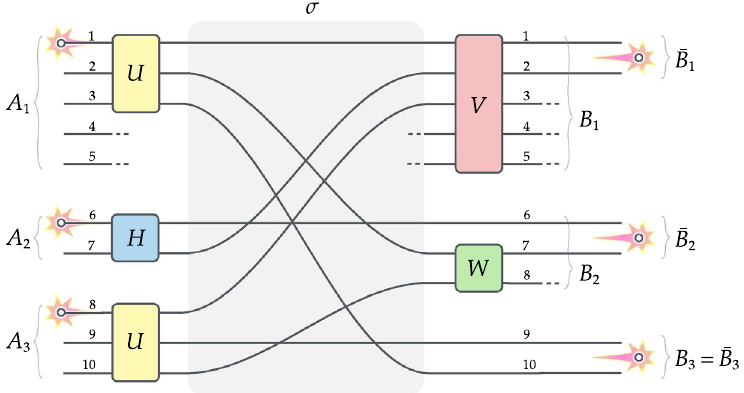
Figure 1. No-touching design for arbitrary state of three qubits. Three independent identical particles entering the optical circuit undergo a sequence of transformations which consists of local unitaries U , H and U on subsystems A 1 , A 2 and A 3 , followed by permutation of the paths σ , and again local unitaries V and W on subsystems B 1 and B 2 . Post-selection on a single particle in each of the dual-rail qubits generates an arbitrary state of three qubits ¯ B 1 , ¯ B 2 and ¯ B 3 in Eq. (2) by the appropriate choice of unitaries in Eq. (6) as specified in Eqs.